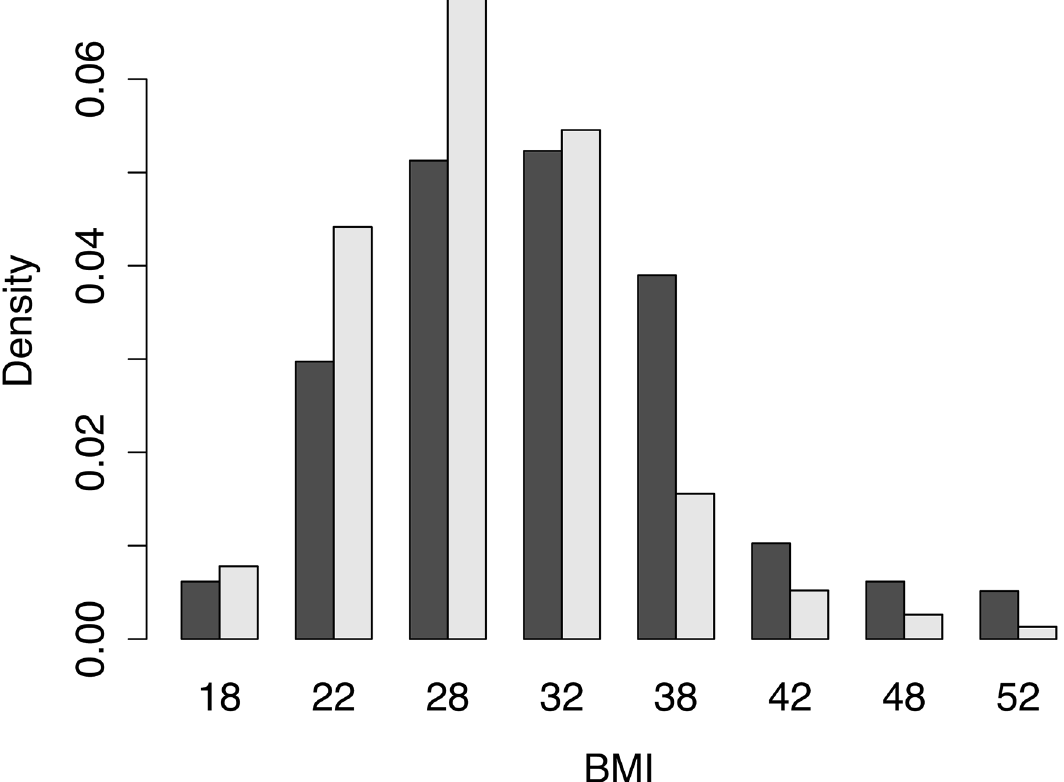
Fig 2. Histogram of BMI values in high-Native American Ancestry group (grey; NA ancestry > 80%) and low-Native American Ancestry group (black; NA ancestry <